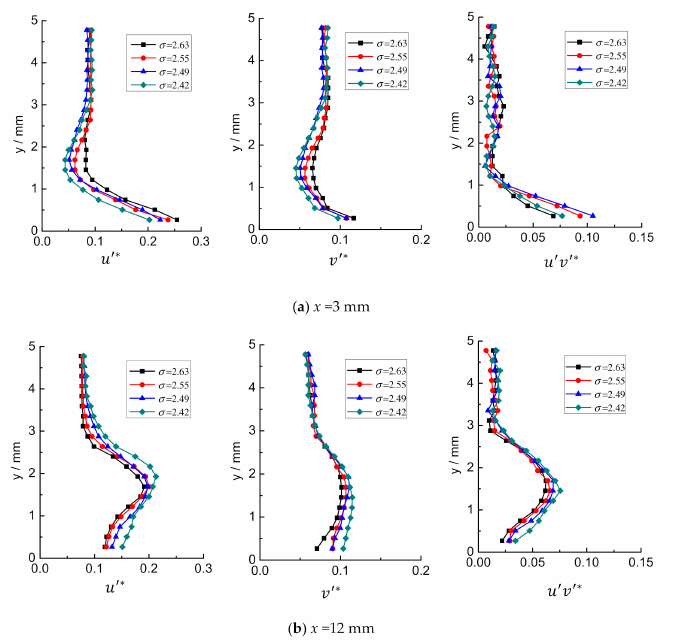
(cid:48)∗ (cid:48)∗ (cid:48)∗ Figure 10. ( a ) Profiles of u , v and u (cid:48) v for di ff erent cavitation numbers at x = 3 mm. ( b ) Profiles of (cid:48)∗ (cid:48)∗ (cid:48)∗ u , v and u (cid:48) v for di ff erent cavitation numbers at x = 12